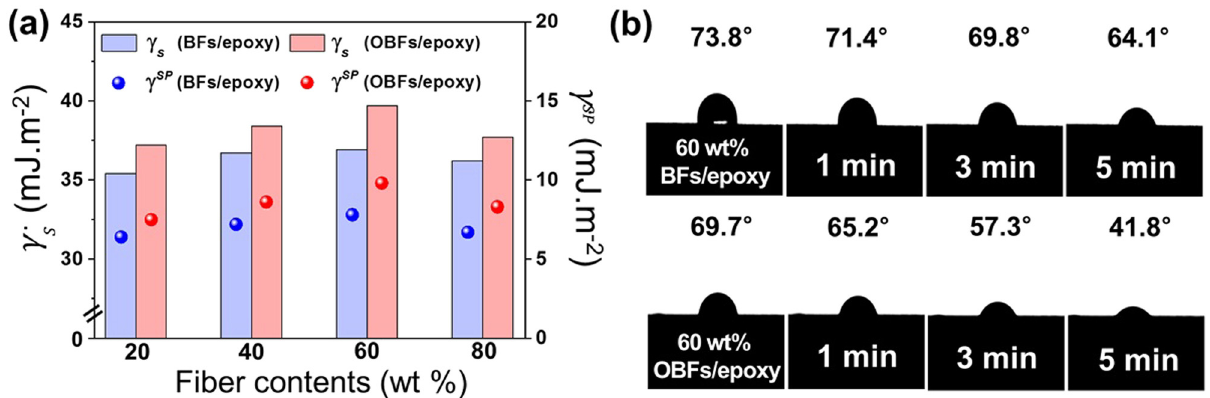
Figure 4: Interfacial interaction of BFs/epoxy and OBFs/epoxy composites: ( a ) surface free energy and ( b ) optical images of the DCA of distilled water over